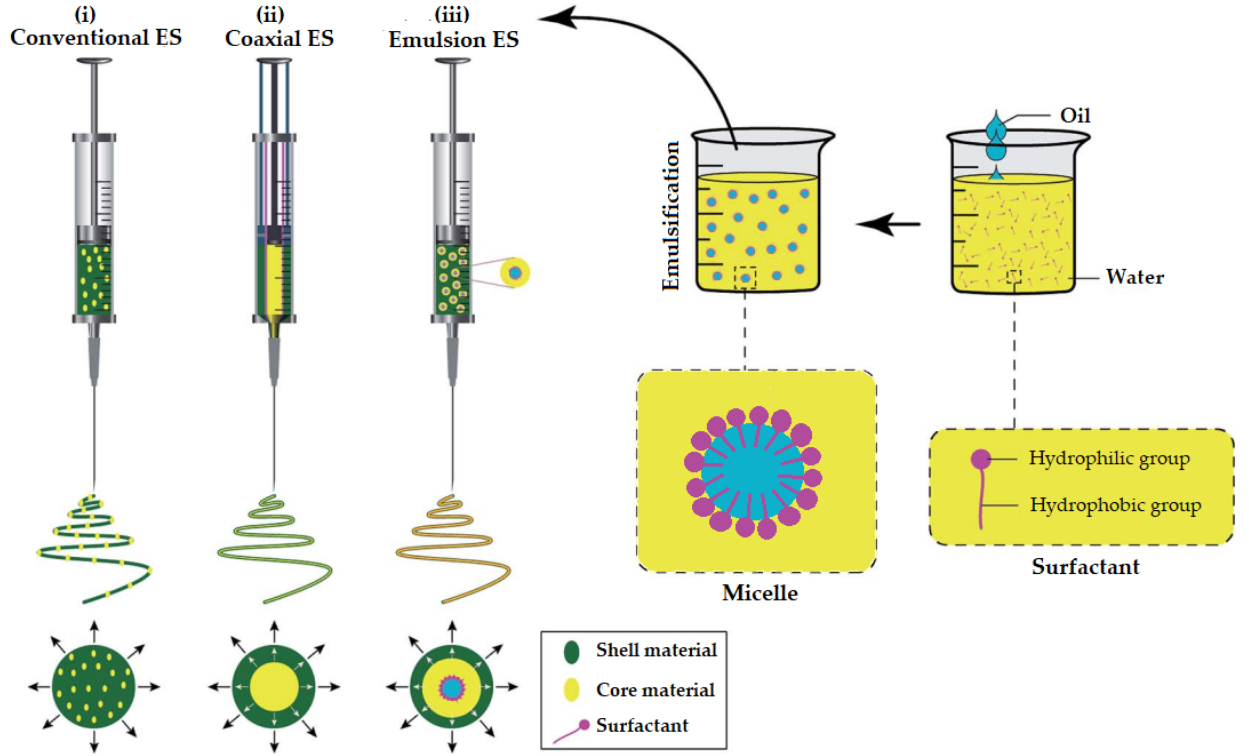
Figure 5. Schematic illustration of spinnerets loaded with different spinning liquids for ( i ) conven- tional (traditional), ( ii ) coaxial and ( iii ) emulsion electrospinning (ES). Adapted with permission (CC BY 4.0) from [47] .